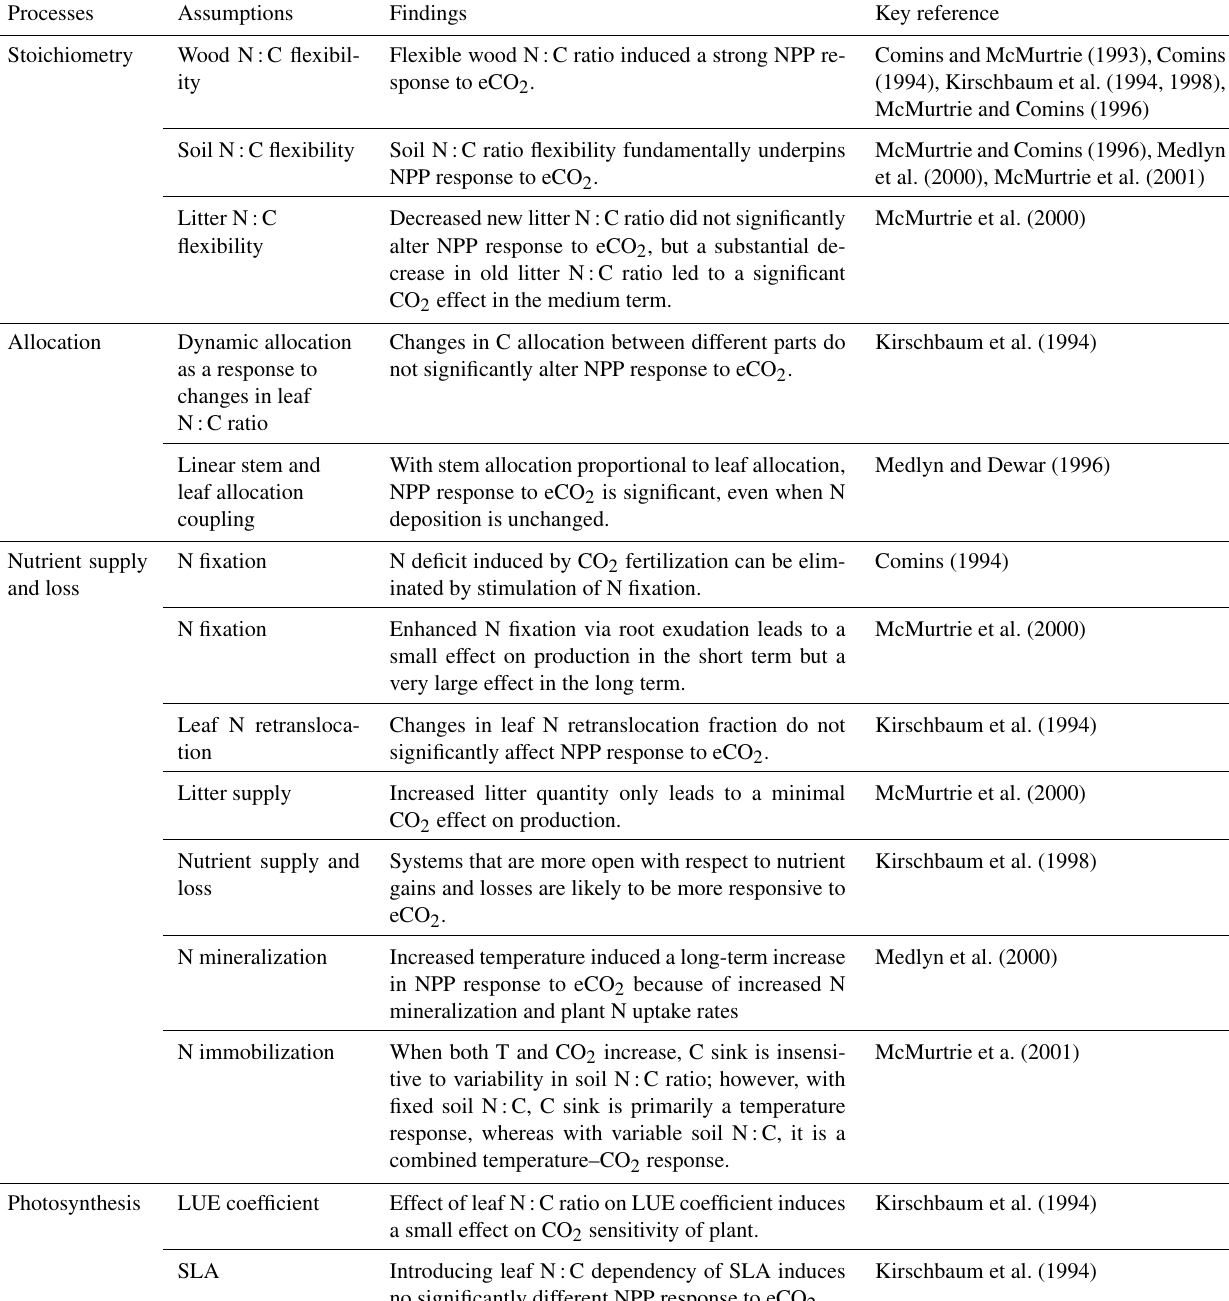
Table 1. A brief summary of the processes and model assumptions evaluated based on the quasi-equilibrium analyses. SLA: specific leaf area; LUE: light-use